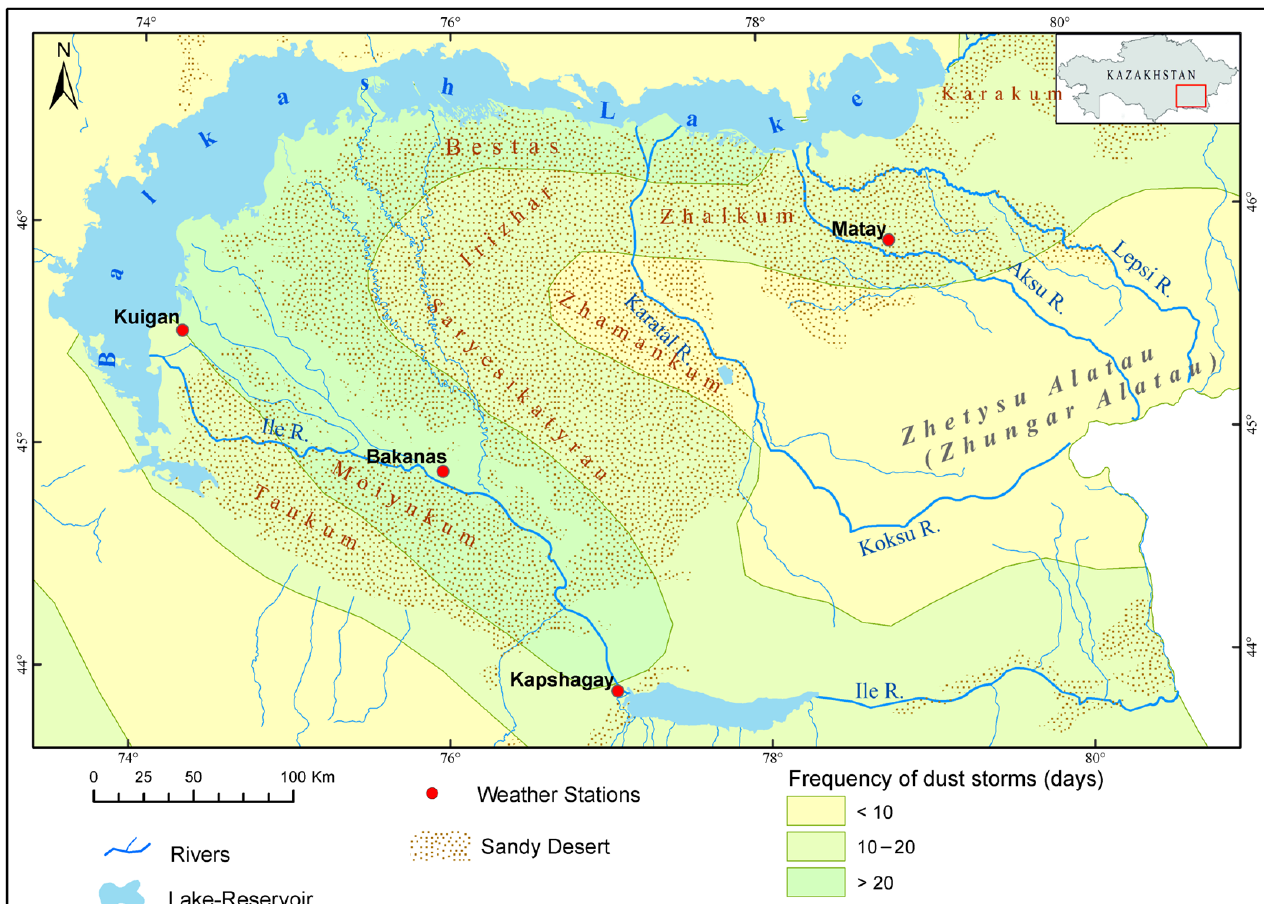
Figure 2. Spatial distribution of dust storms in the Southern Balkash deserts.